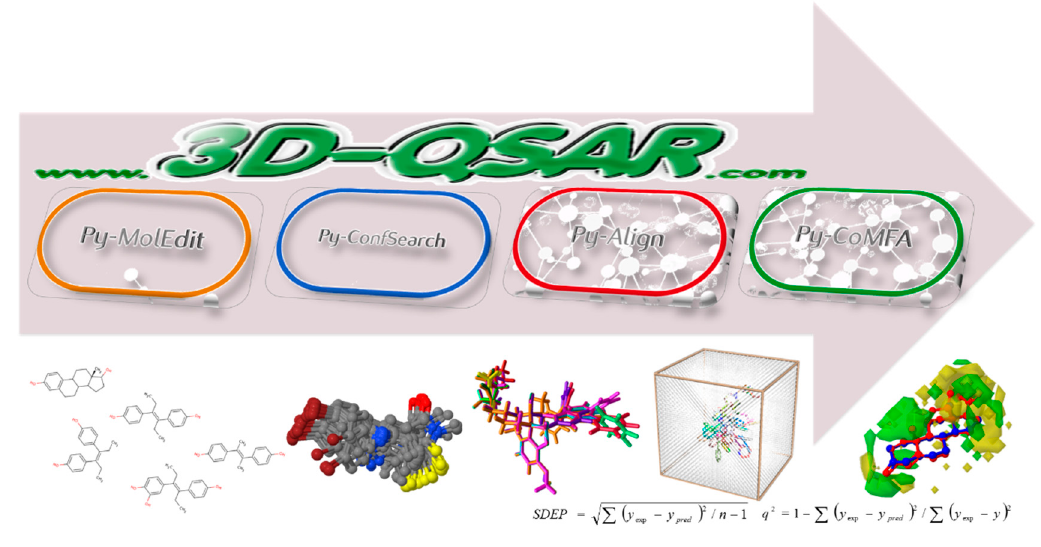
Figure 1. 3-D QSAR modeling workflow as implemented in